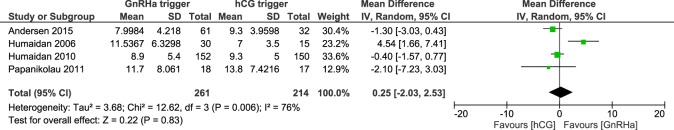
GnRH agonist (GnRHa) trigger versus hCG trigger, important outcome Oocytes retrieved/intention to treat.